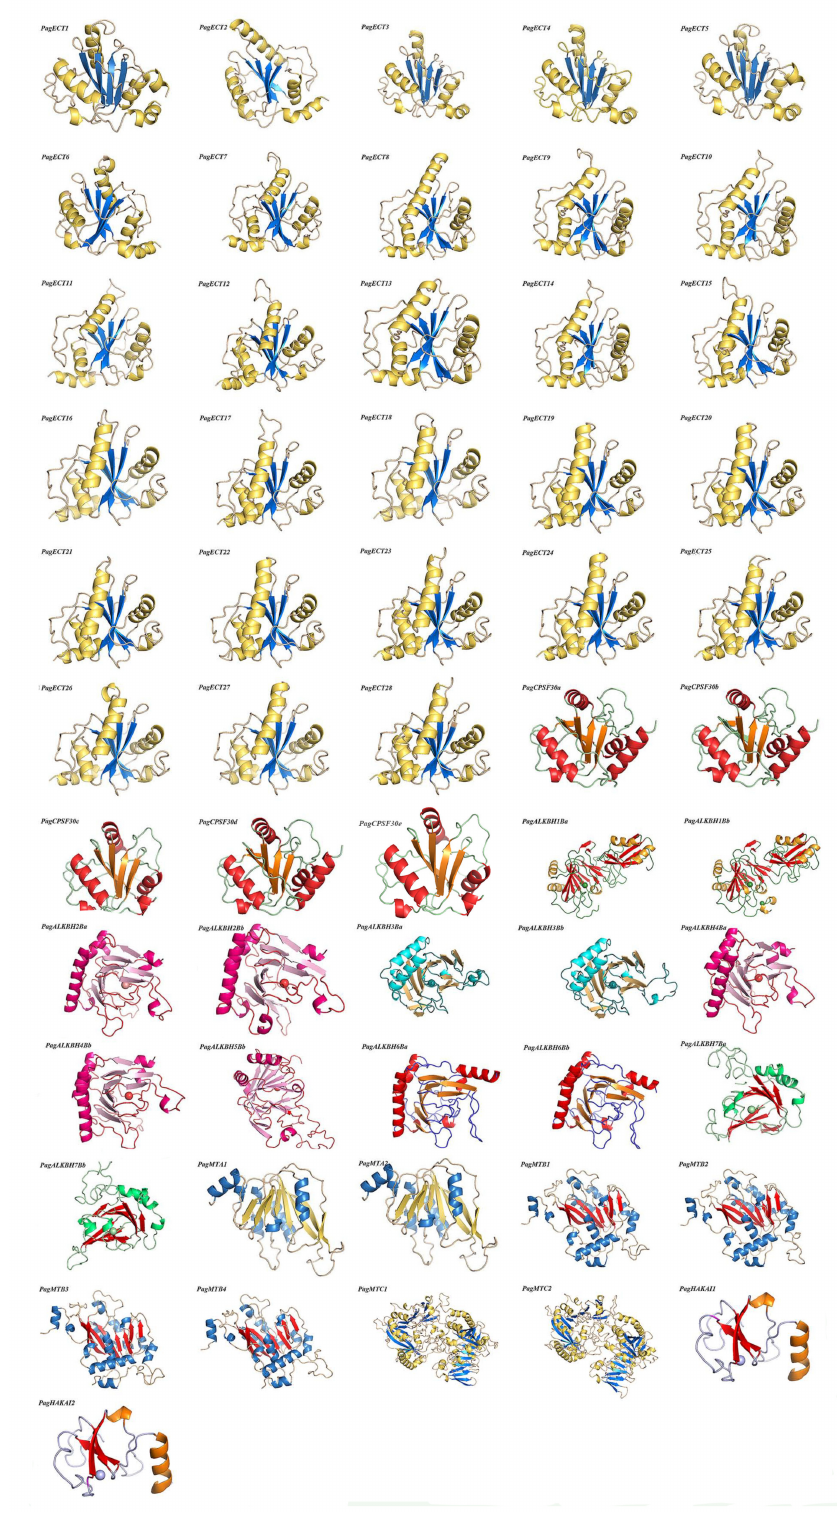
Figure 7. The homology modeling of m 6 A pathway genes in Poplar 84K. The α -helix, β -fold and random coil are shown, and the ball representsmetal